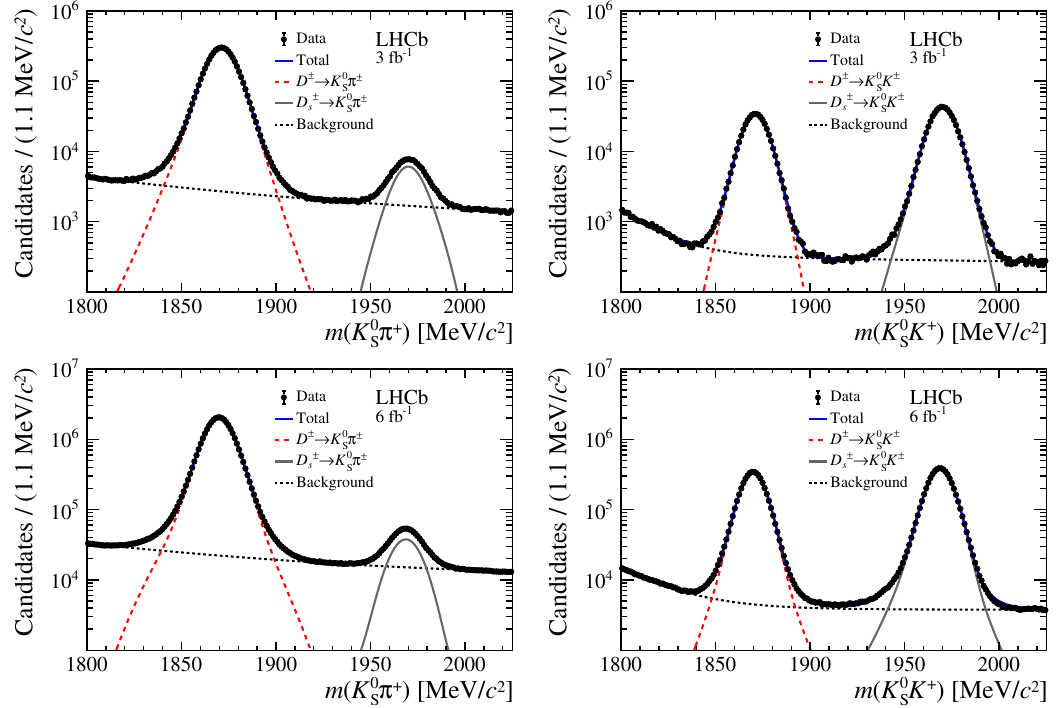
Figure 4. Distributions of the (left) m ( K 0 candidates in (top) Run 1 and (bottom) Run 2. The total PDF and individual fit components are overlaid, including D + → K 0 background decays in dashed